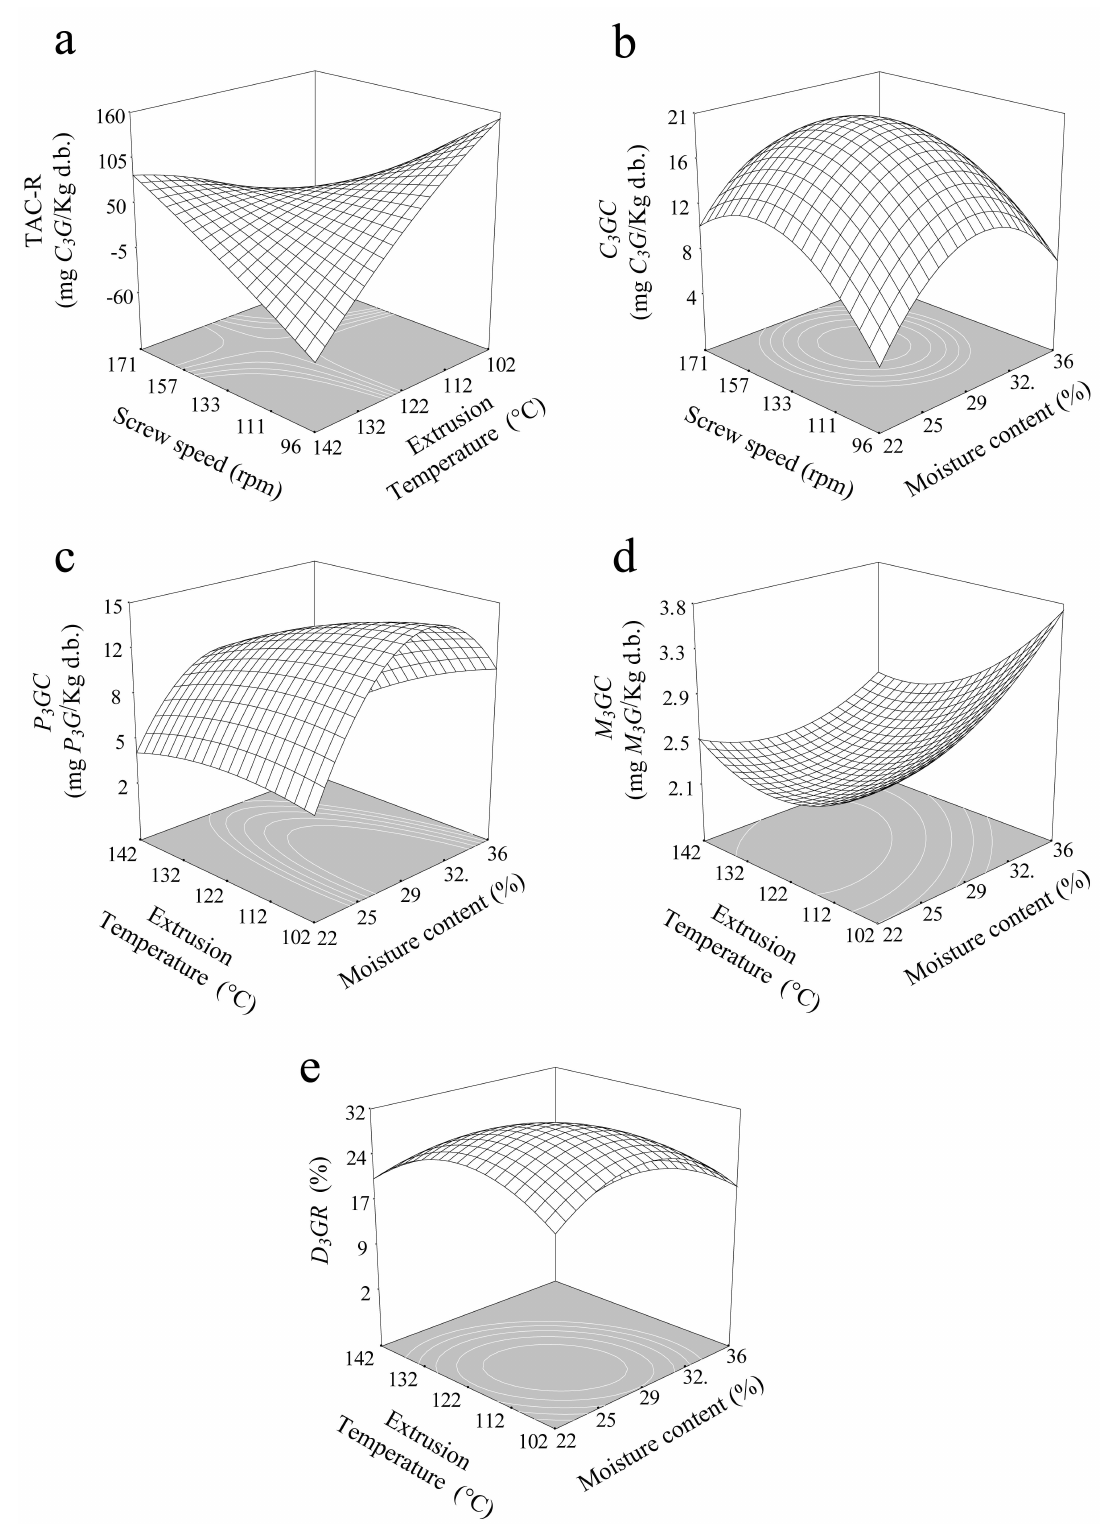
Figure 2. Effect of extrusion temperature, screw speed and moisture content: ( a ) TAC-R = difference of anthocyanin content, ( b ) C 3 GC = cyanidin-3-glucoside content, ( c ) P 3 GC = pelargonidin 3-glucoside content, ( d ) M 3 GC = malvidin 3-glucoside content and ( e ) D 3 GR = retention percentage of delphinidin 3-glucoside chloride in MWSE. Pelargonidin-3-glucoside content presented similar trend as C 3 GC (Figure 1c). The adjusted model shows a saddle point of 3.68 mg P 3 G /kg in TGSE. On the other hand,